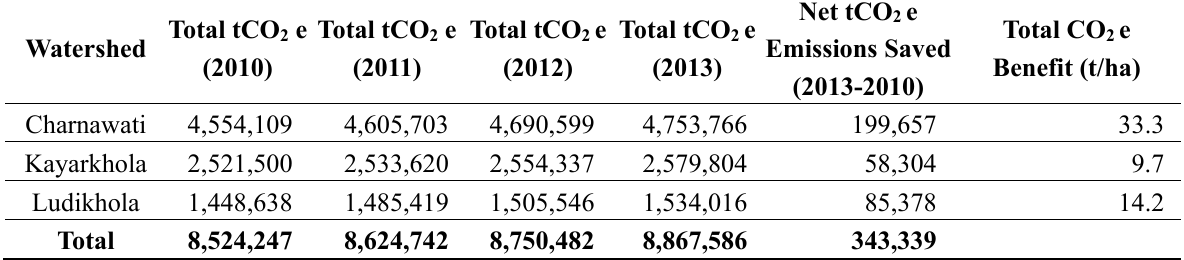
Figure 2. Trend line showing carbon stock per unit area in the three watersheds. Table 5. Total Carbon-dioxide equivalent